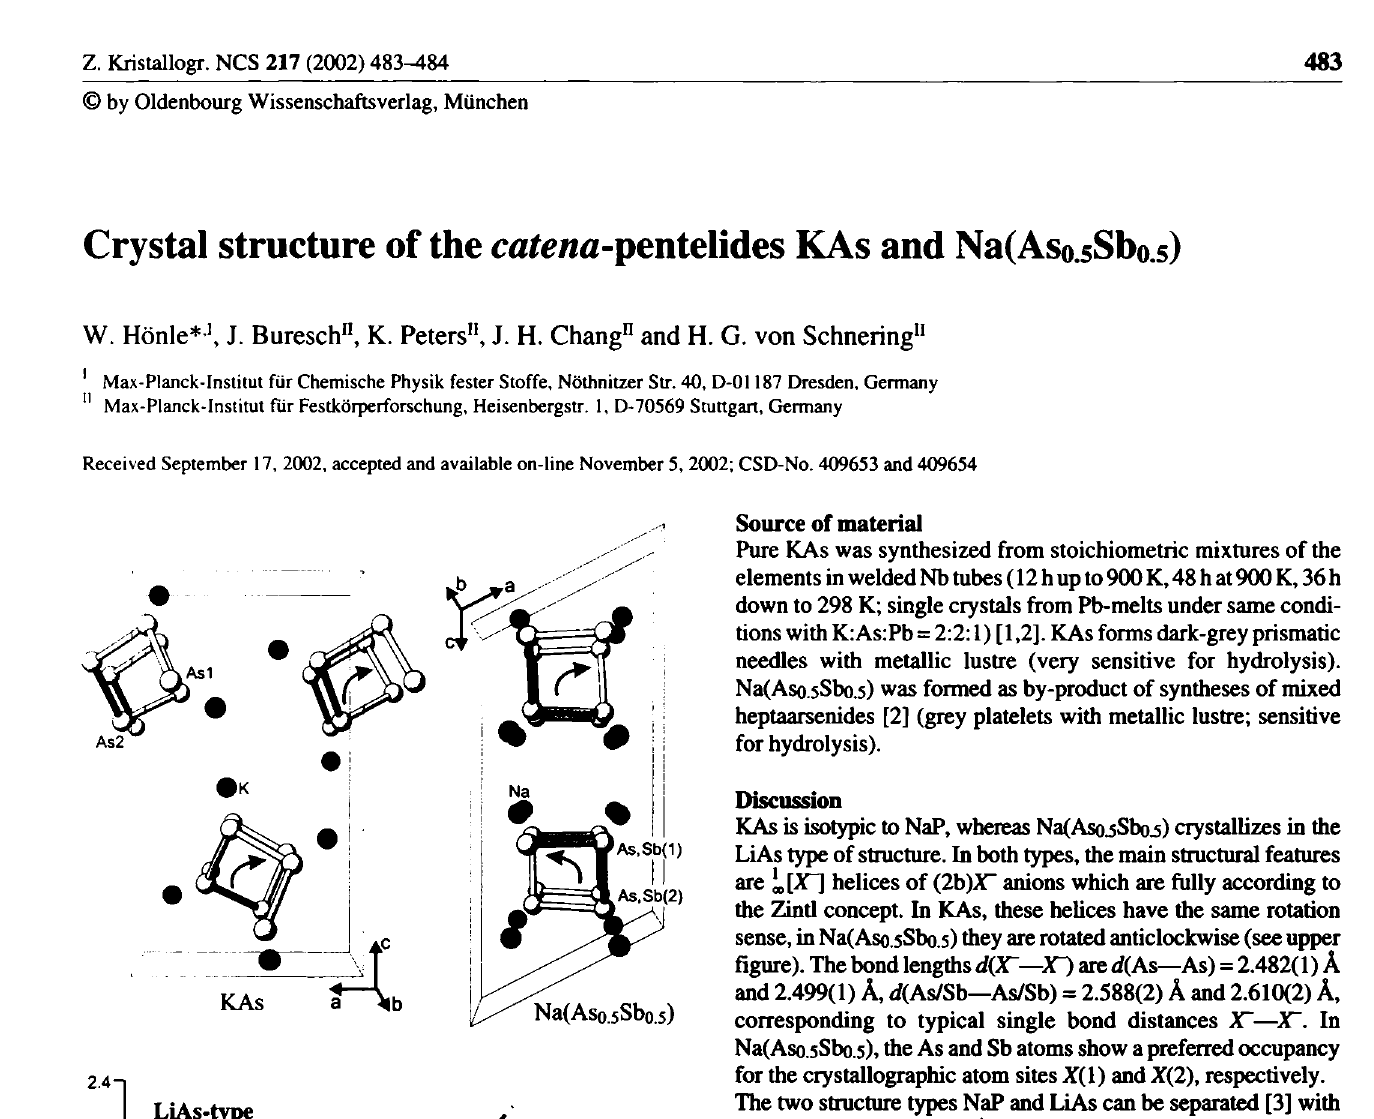
Table 1. Data collection and handling.